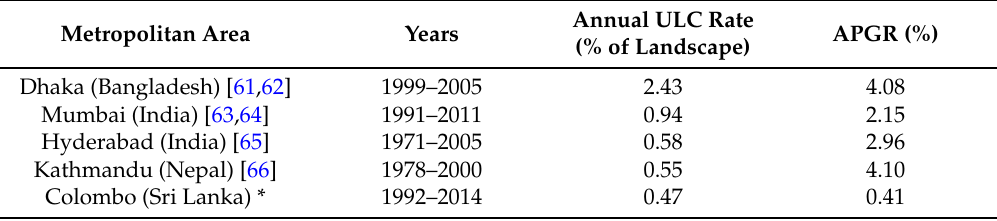
Table 2. Built-up and population growth in selected South Asian metropolitan